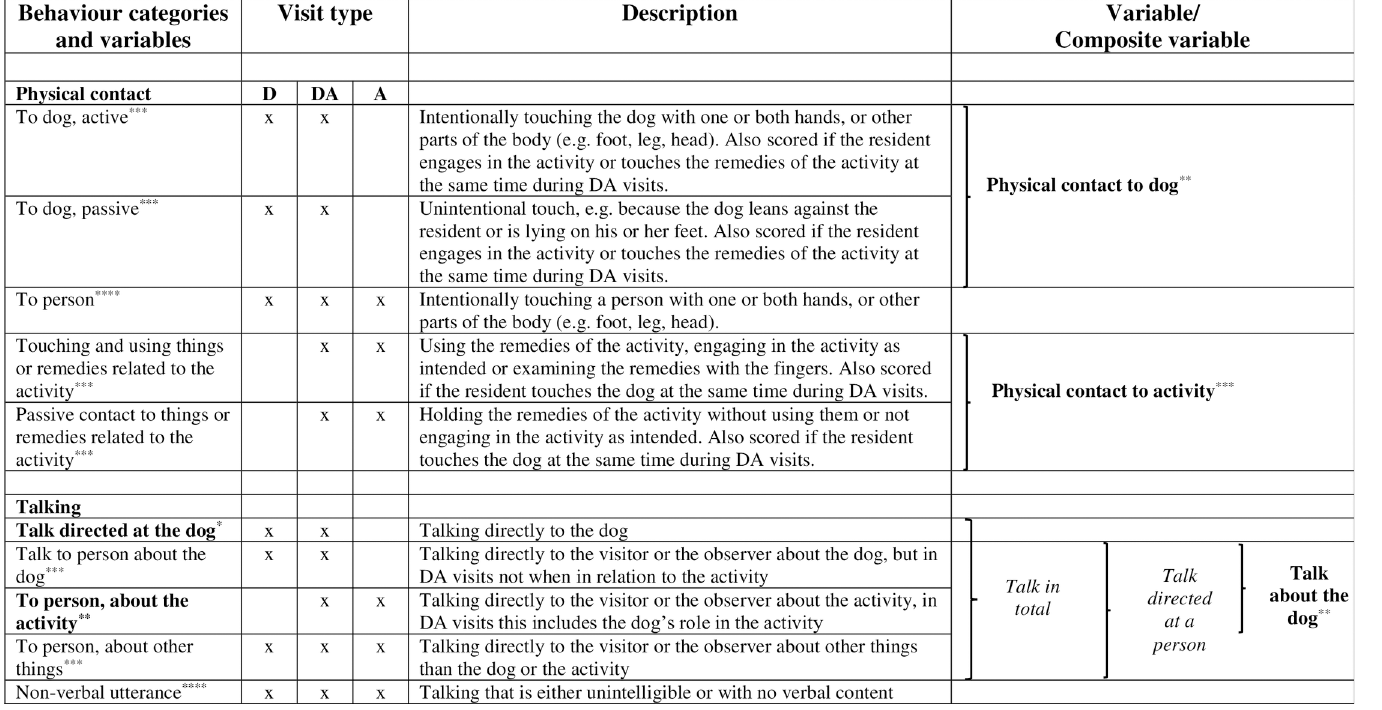
Fig 2. Ethogram, composite variables and use of statistical models. The column “Variable/Composite variable”, shows the components of the composite variables. The use of statistical models is indicated with bold text for the generalised linear mixed model (Likelihood of occurrence, in bold), italics for non-parametric analysis (duration, in italics). The cut-off for the binary variables in the generalised linear mixed models could be either 0 or 60 seconds, indicated by � and �� , respectively. ��� Not analysed separately, ���� Not analysed.